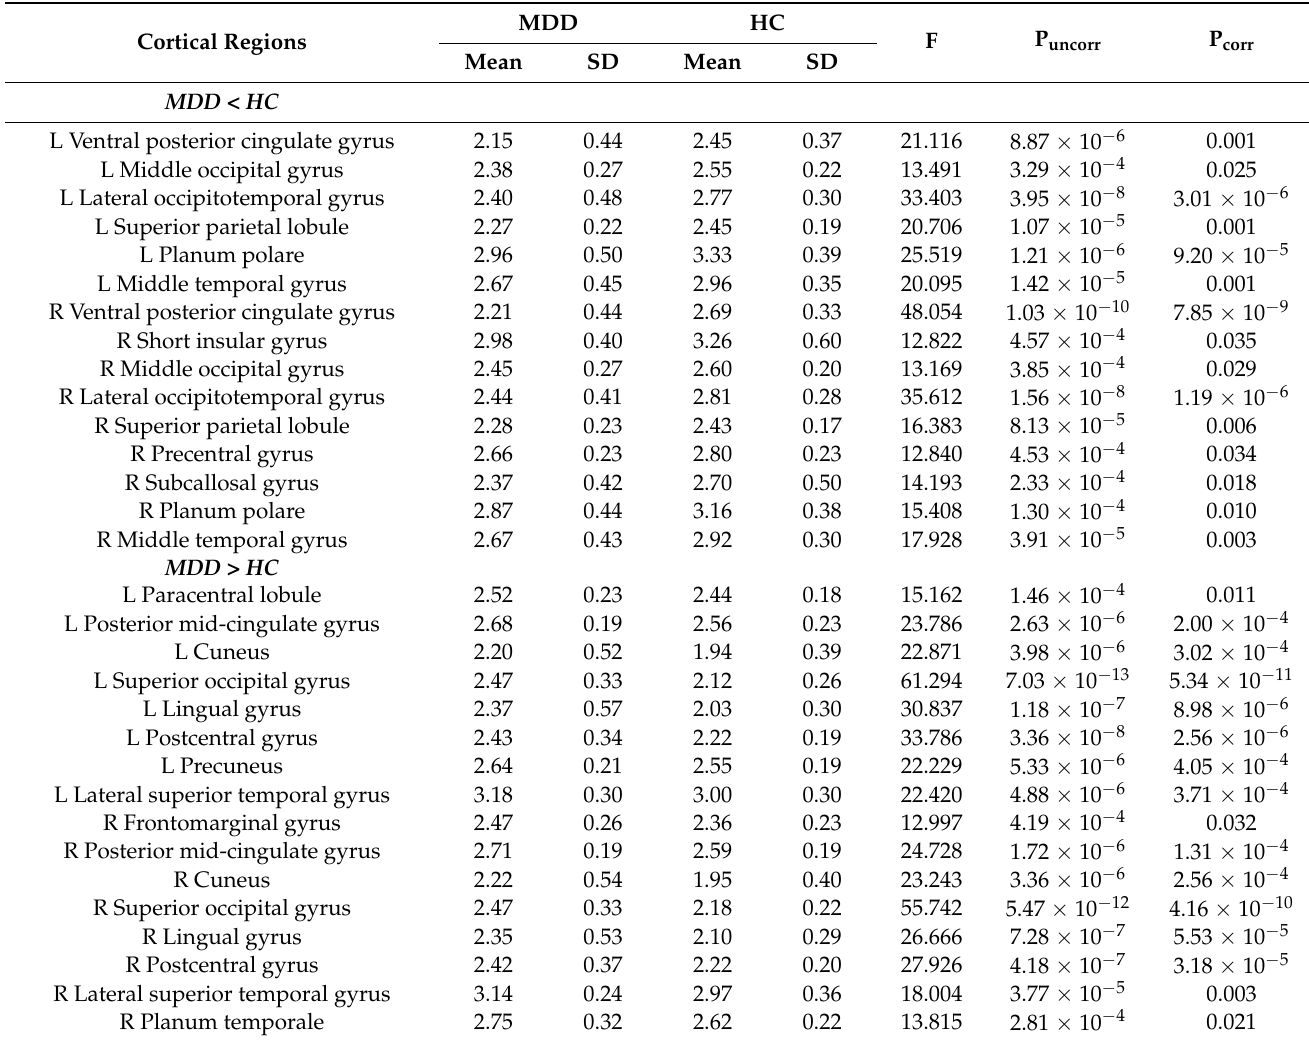
Table 3. Cortical thickness comparisons between patients with MDD and